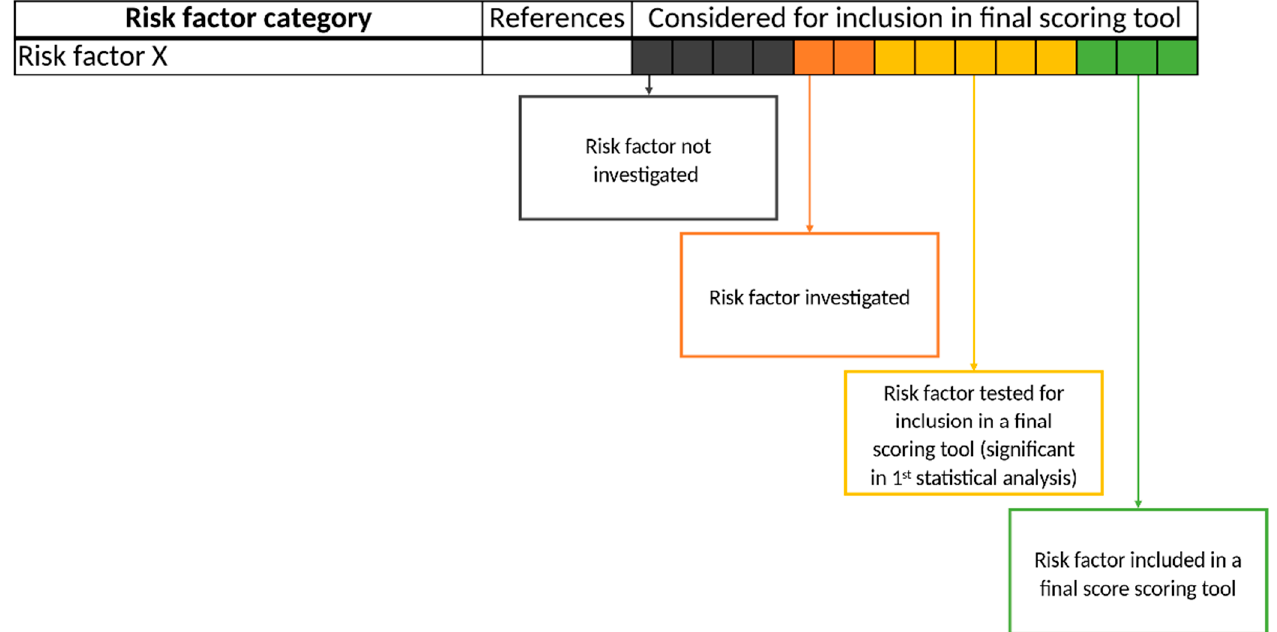
Figure 1. Schematic presentation of risk factors in the form of a color-coded table. Each of the 14 boxes represents one of the included studies. The color of the boxes portrays whether a risk factor was not investigated in a study (gray), was investigated (orange), was significant in a first statistical analysis or based on expert consensus and therefore tested for inclusion in a final scoring tool (yellow), or whether a risk factor was included in a final scoring tool (green). The “citations”-column lists each study that at least investigated the respective risk factor.